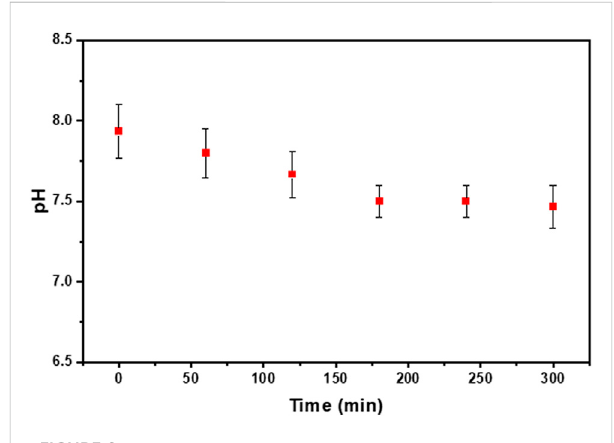
FIGURE 9 pH trend in solution probed during the treatment